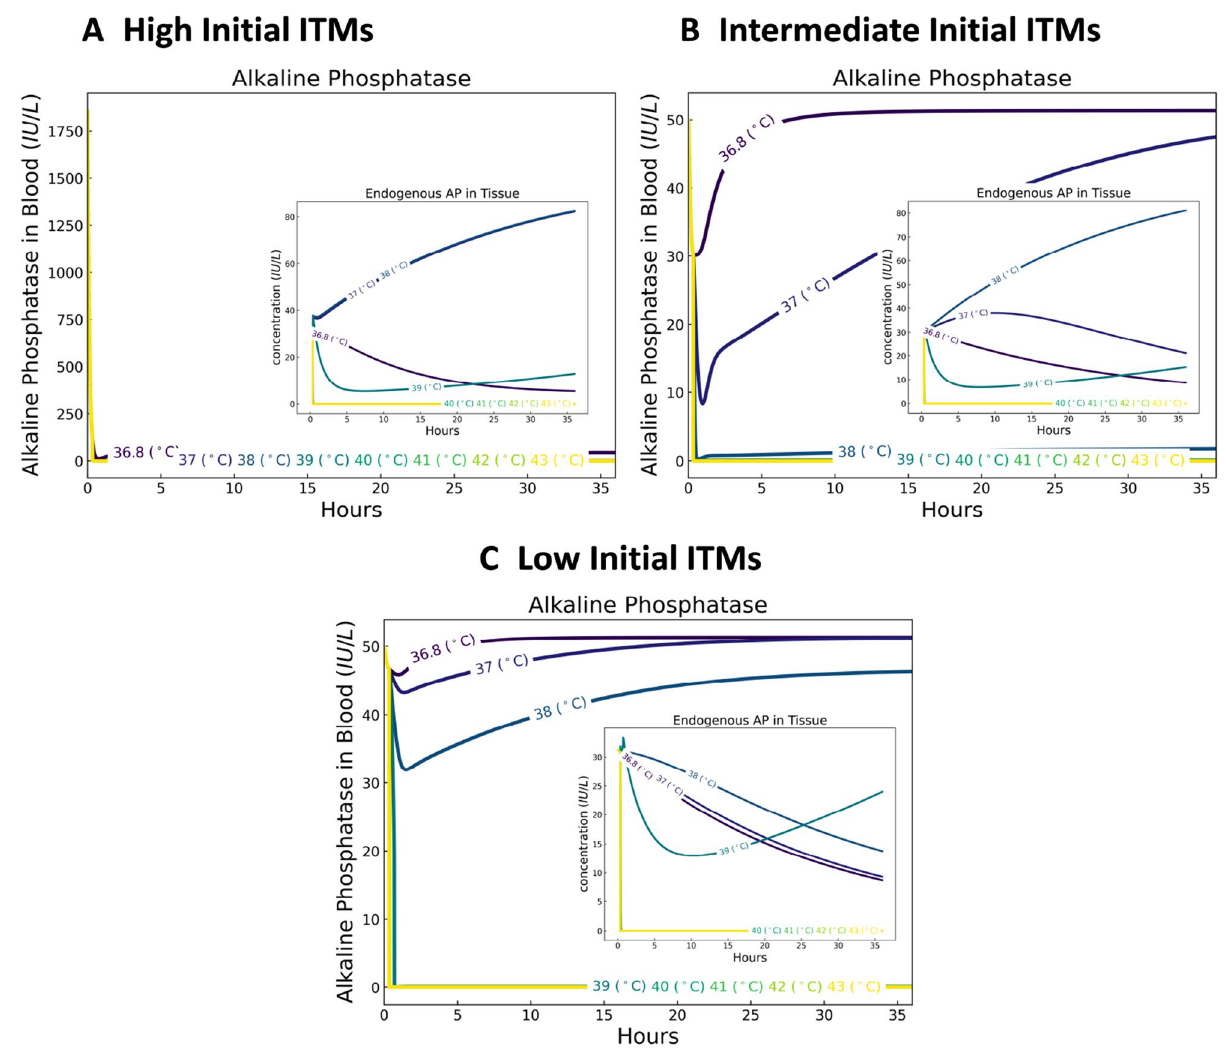
Figure 9. Dynamics of alkaline phosphatase in blood (main) and tissue (inset) for a temperature-dependent human innate immune system. At high initial levels of ITMs (A) , all temperatures trigger the diffusion of AP from the bloodstream into the tissue. For healthy individuals with low initial ITMs (C) , AP in the bloodstream is less used by the body, as evident from the subtle dips in AP concentrations. For intermediate initial ITMs (B) represented by individuals belonging to disadvantaged groups, results show slightly more consumption of AP for low core temperatures as compared to healthy Alkaline phosphatase. Alkaline phosphatase helps in neutralising inflammation. Hence, the stronger the stimu- lus is (that is, the more ITMs there are in the body) the more AP is induced to fight the ongoing inflammation. Alkaline phosphatase concentrations in blood as well as in tissue are shown in Fig. 11. The snippets correspond to the same AP concentrations plotted for a period of 120 hours or 5 days. Here we show that a marathon, the physical activity that contributes most of the ITMs, induces the strong- est surge of AP from the bloodstream into the tissue (see Fig. 11) and immediately uses it up to neutralise the ongoing inflammation. This is followed by construction work and walking. During the course of the activities, AP is consumed by the body, more for marathon than the two activities, to neutralize the ongoing inflammation. After some time, when the inflammation is nearly resolved for all activities, we see an increase in AP in blood as the the concentration goes back to normal.